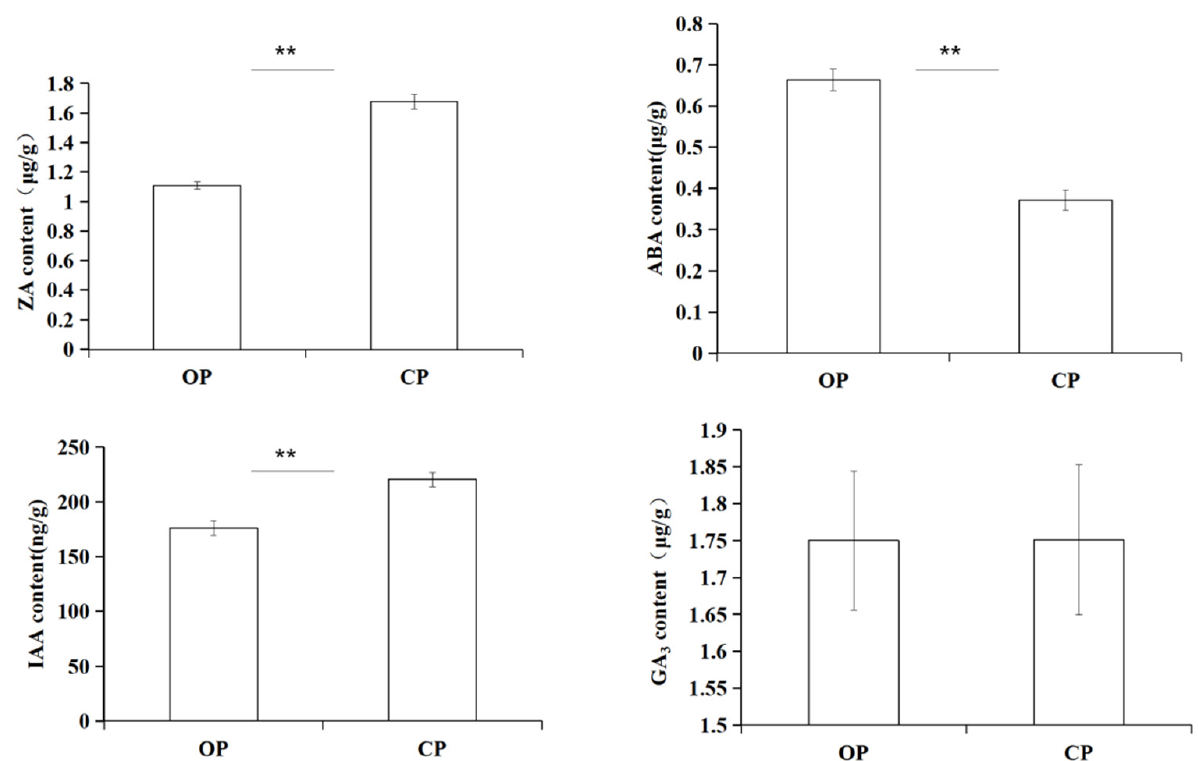
Figure 1. Content changes of ZA, ABA, IAA and GA 3 hormones during OP and CP periods. ** Differences were considered extremely significant at p < 0.01.